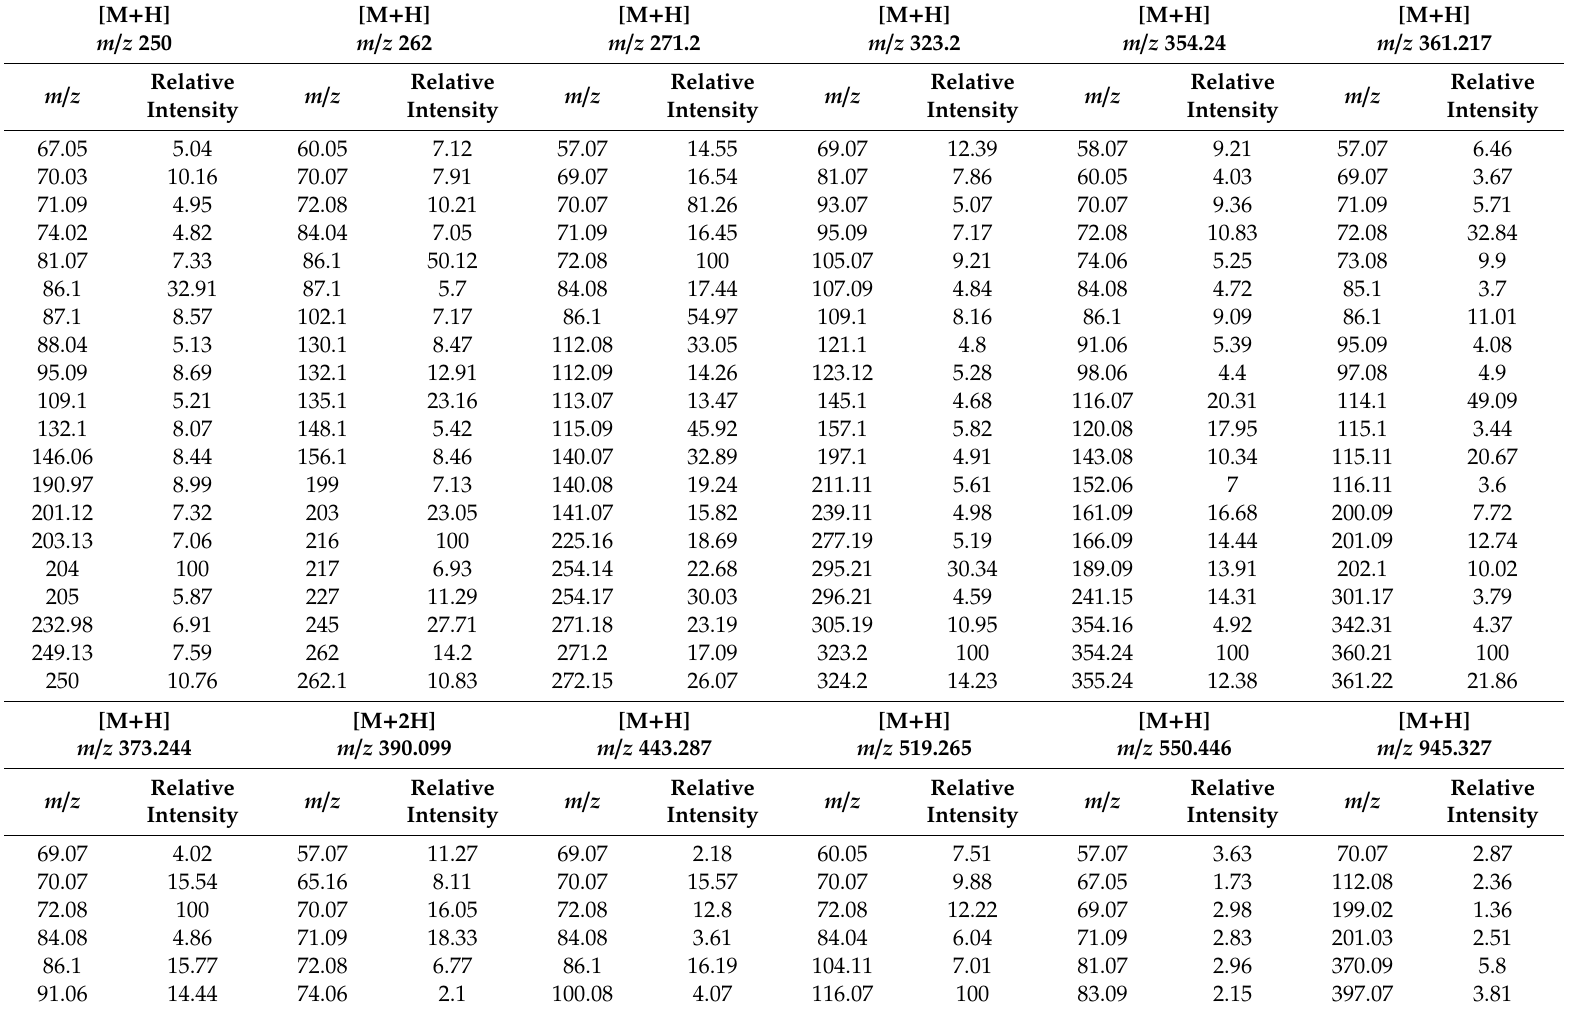
Table A4. The MS2 peak lists of the uncharacterized metabolites detected specifically in A. musiformis